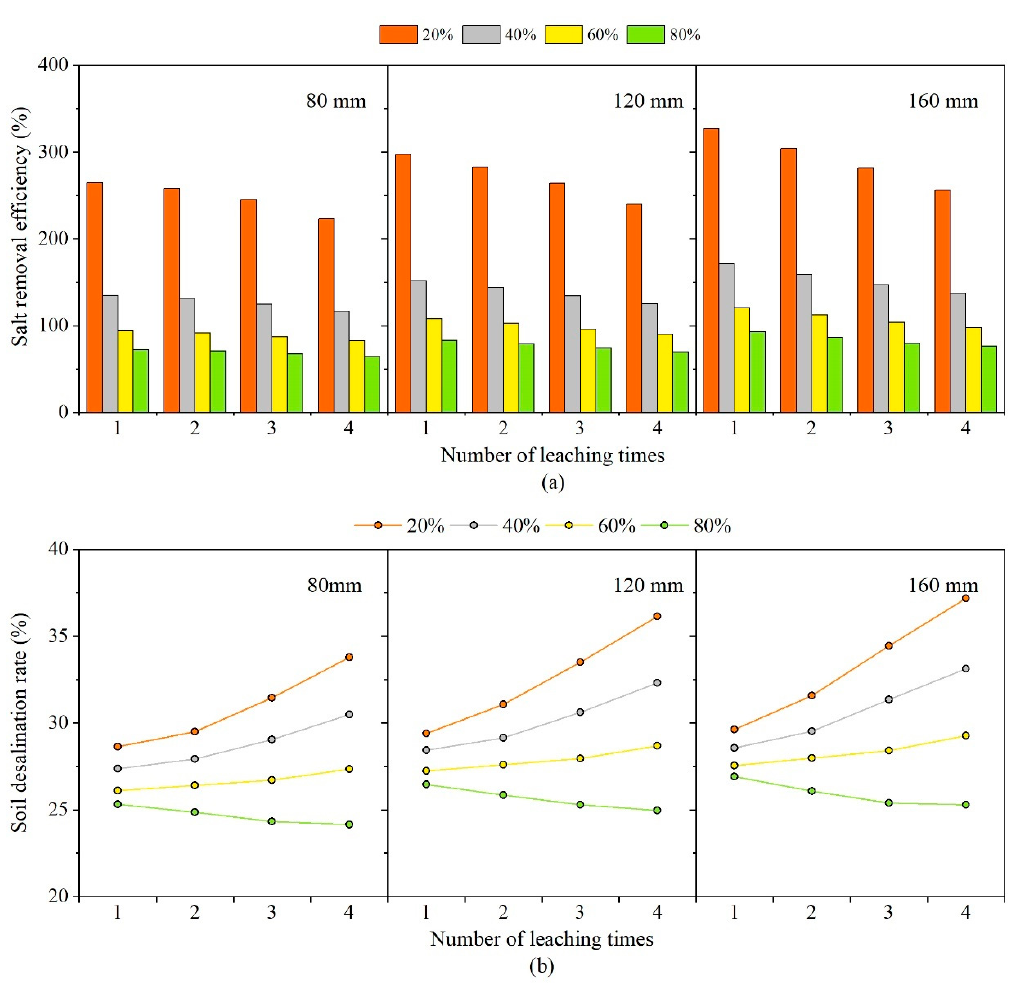
Figure 11. Variation of salt removal efficiency ( a ) and soil desalination rate ( b ) with increasing number of leaching events.